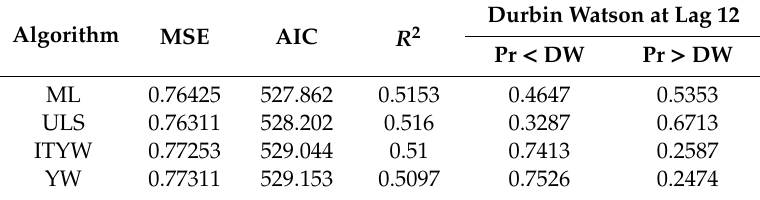
Table 4. Analysis of the errors produced by the autoregressive model with the four algorithms.